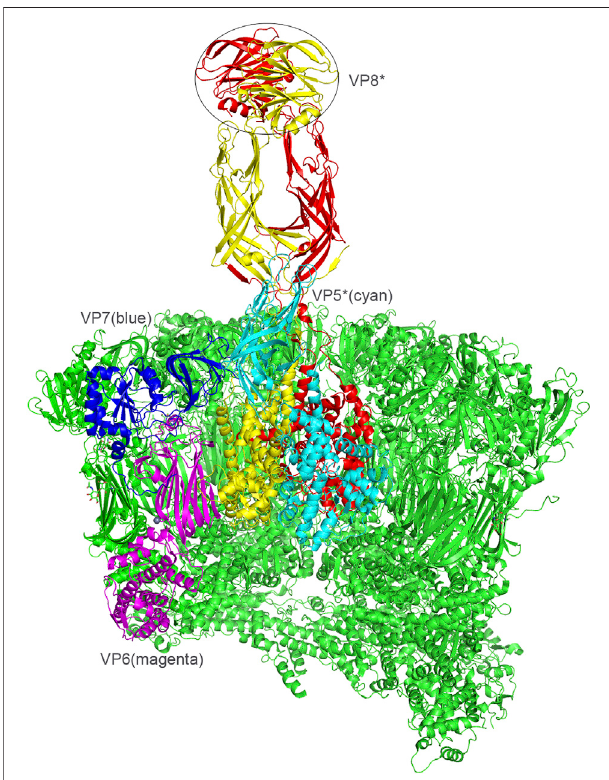
FIGURE 1 | Presentation of the RV viral proteins of the middle and outer layers based on the rotavirus particle structure (PDB: 4V7Q). VP6, magenta. VP7, blue. VP4, red/yellow. VP5, cyan. VP8*, the distal domain of VP4 was shown in a circle.